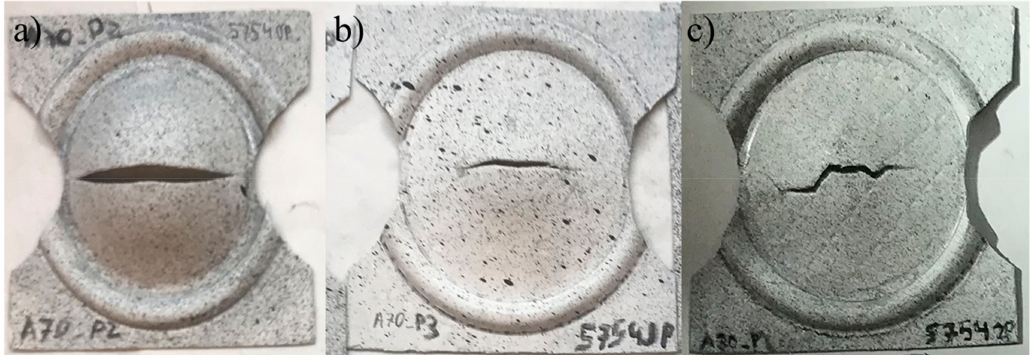
Figure 7. Comparison of the fractures after the Nakajima tests in samples with ( a ) zero ( b ) one and ( c ) two RCS